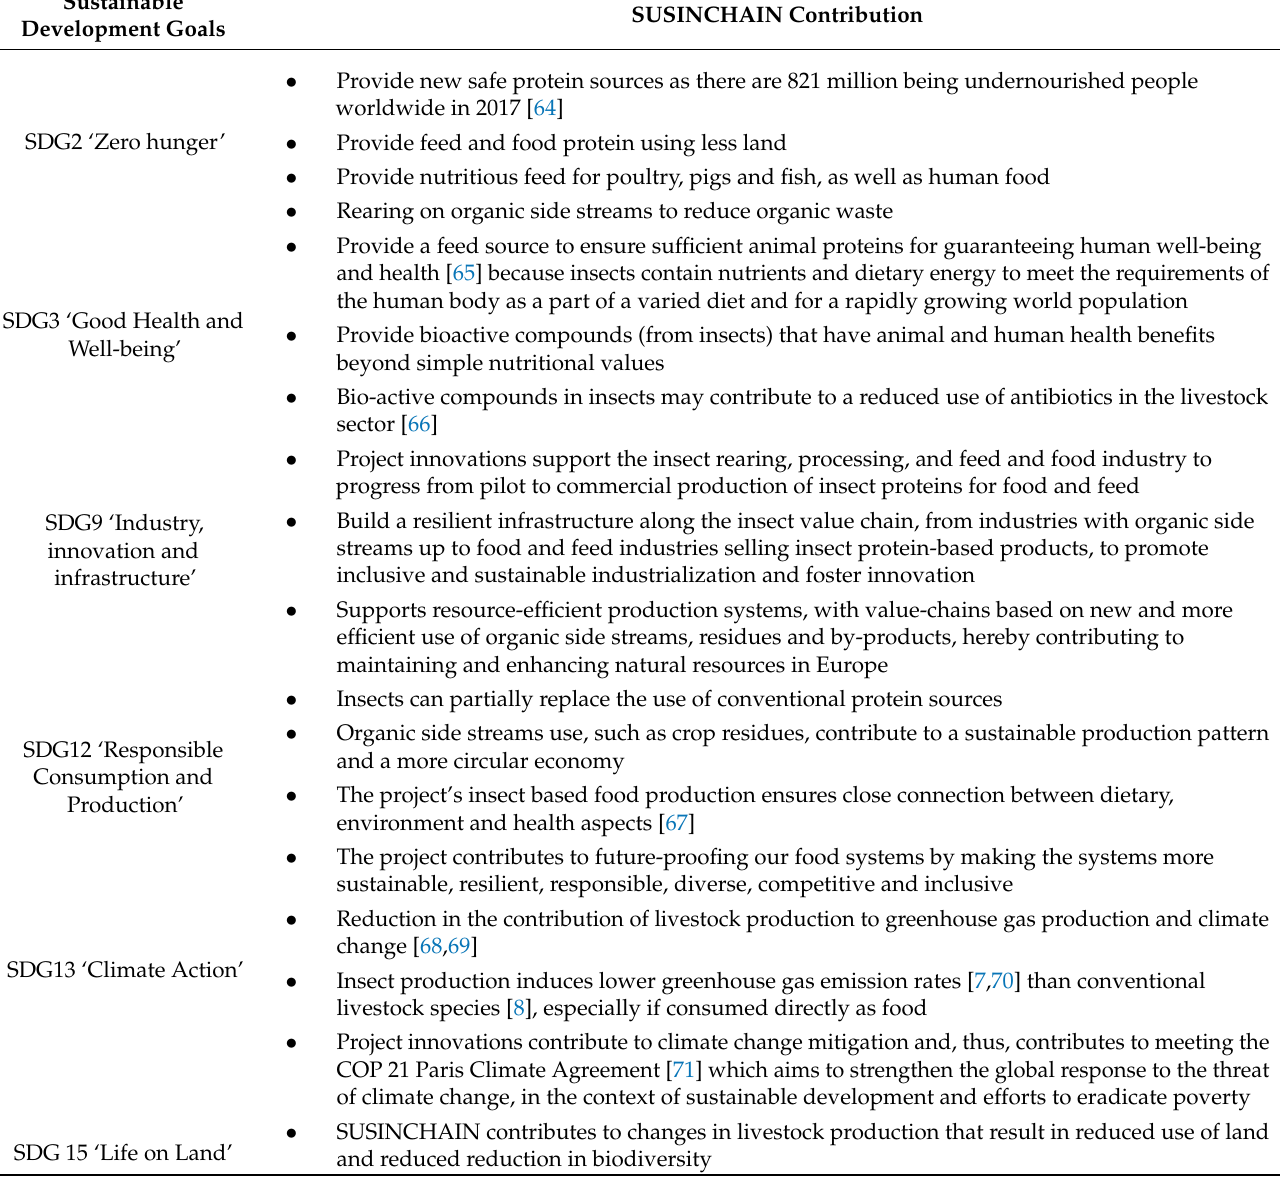
Table 1. The contribution of the SUSINCHAIN project to the anticipated